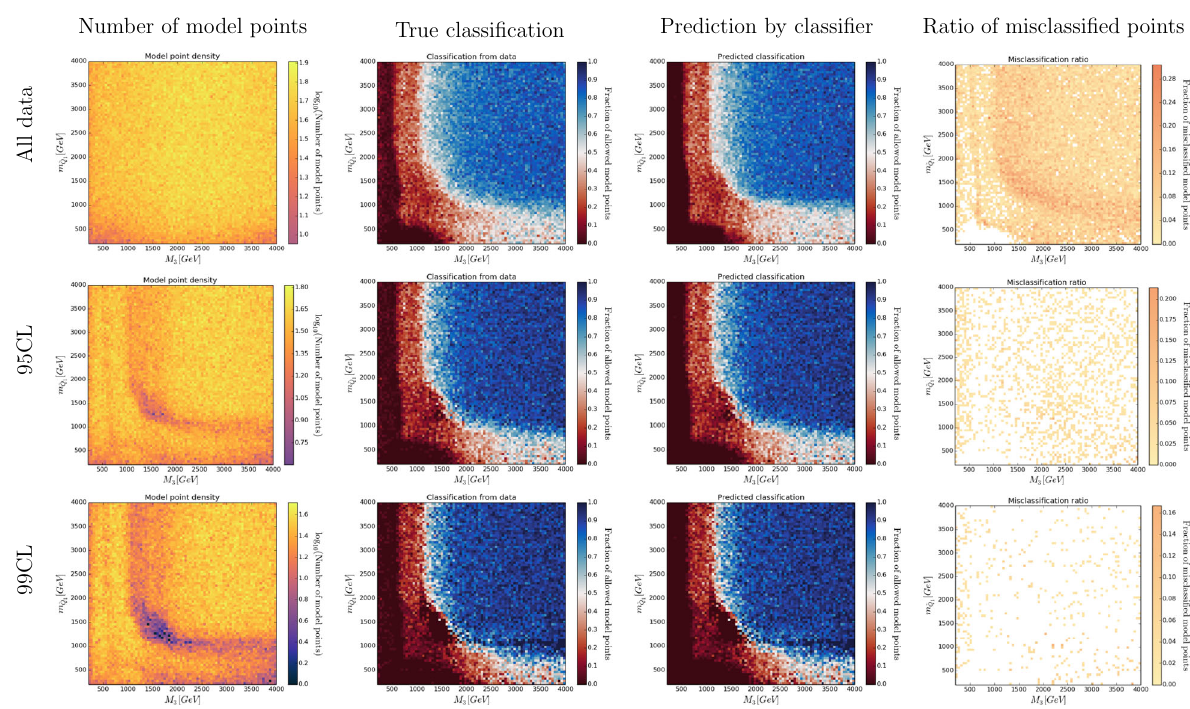
Fig. 19 Color histograms for a projection of the 19-dimensional the true classification and the out-of-bag prediction, respectively. The last column shows the fraction of misclassified model points pMSSM parameter space on the M 3 – m (cid:2) Q plane. The color in the sec- 1 ond and third column indicates the fraction of allowed data points for